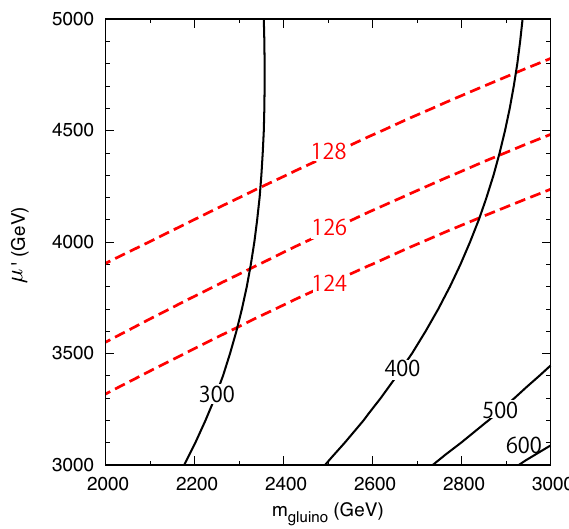
Figure 2 . The contours of (cid:1) (black solid) and m h (red dashed), where m h is shown in units of GeV. We take M mess = 500 TeV, (cid:21) = 0 : 9 and tan (cid:12) = 4 : 0. The other parameters are same as in (cid:12)gure